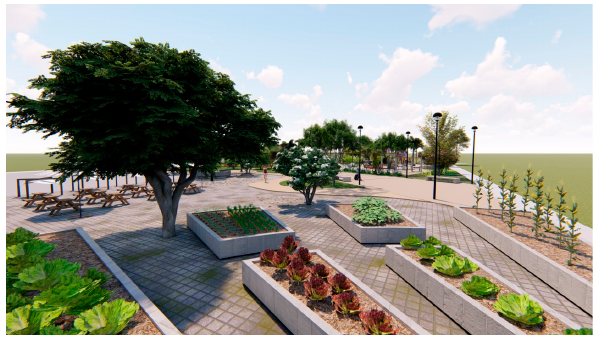
Figure 14. Vegetable garden.